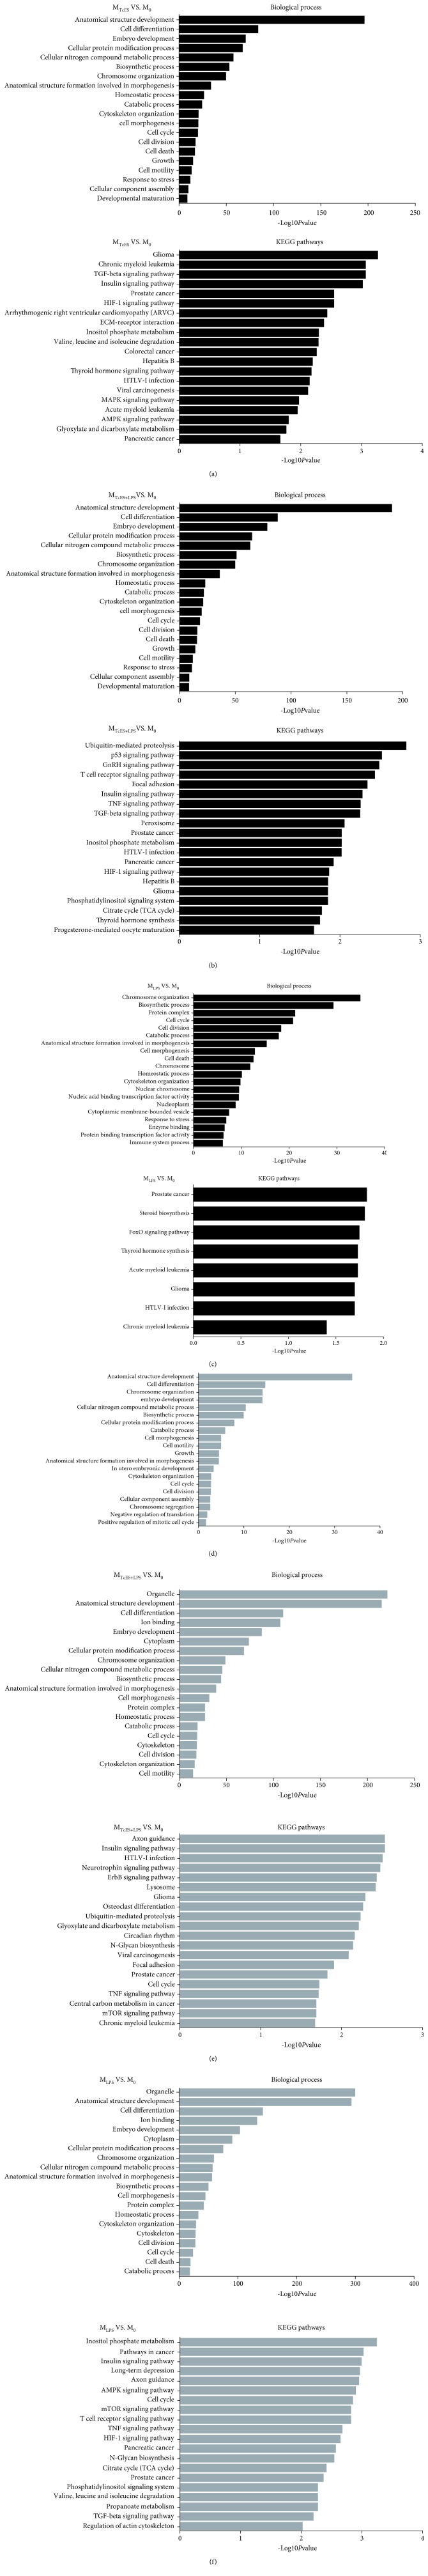
Top 20 of GO biological processes and KEGG pathways in MTcES, MTcES+LPS, and MLPS at 4 (black) and 24 h poststimulus (gray). GO biological processes and KEGG pathways enriched by the upregulated differentially produced microRNAs between MTcES vs. M0 (a and d), MTcES+LPS vs. M0 (b and e), and MLPS vs. M0 (c and f) at 4 h and 24 h poststimulus, respectively.